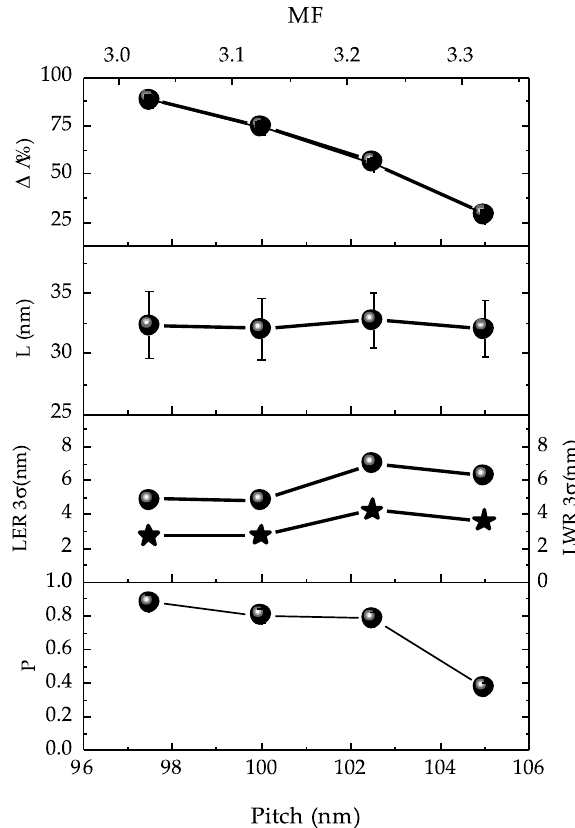
Figure 6. Evolution of ∆ (%), period L, line edge roughness (LER) (stars), line width roughness (LWR) (spheres), and Herman’s orientational (P) parameter as a function of the TEOS pitch size and multiplication factor (MF) in L32 BCP thin films.